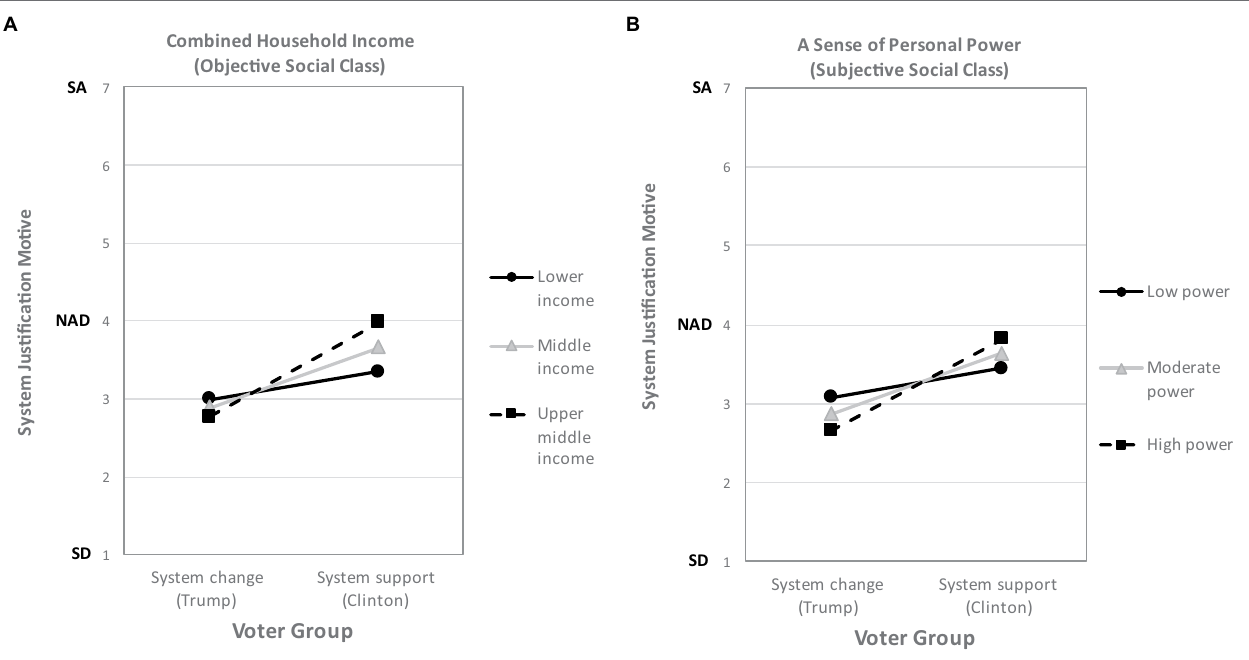
FIGURE 2 | The effect of voter group on the system justification motive is qualified by indicators of objective (A) and subjective (B) social class. SA, strongly agree; NAD, neither agree nor disagree (unsure); and SD, strongly disagree.